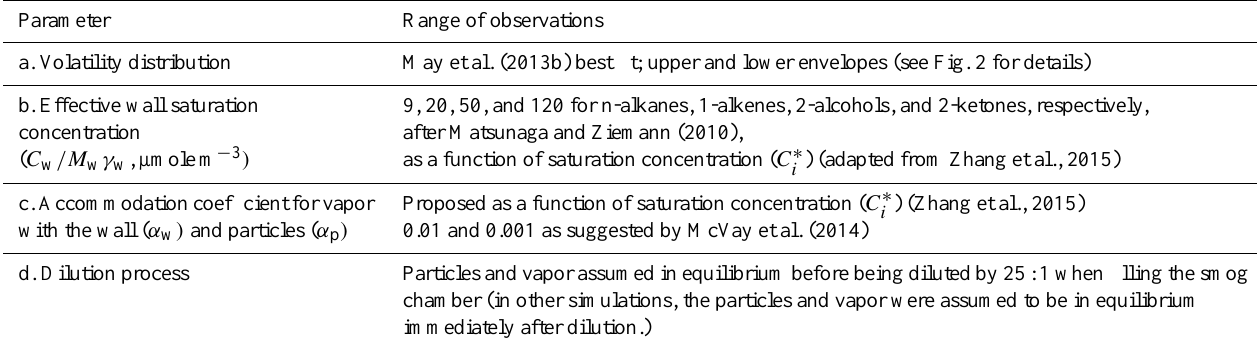
Table 4. Sensitivity tests varying the input